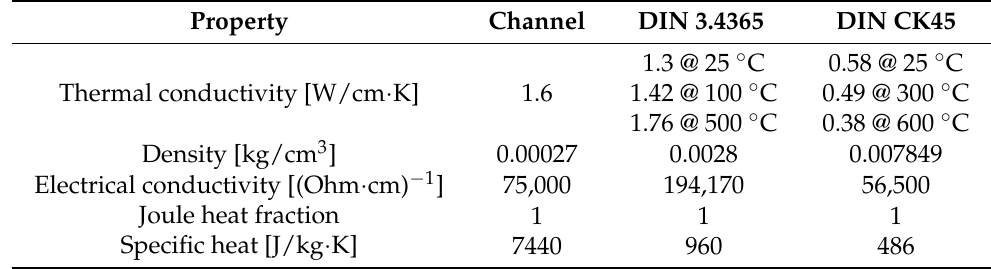
Table 1. Material properties [7].